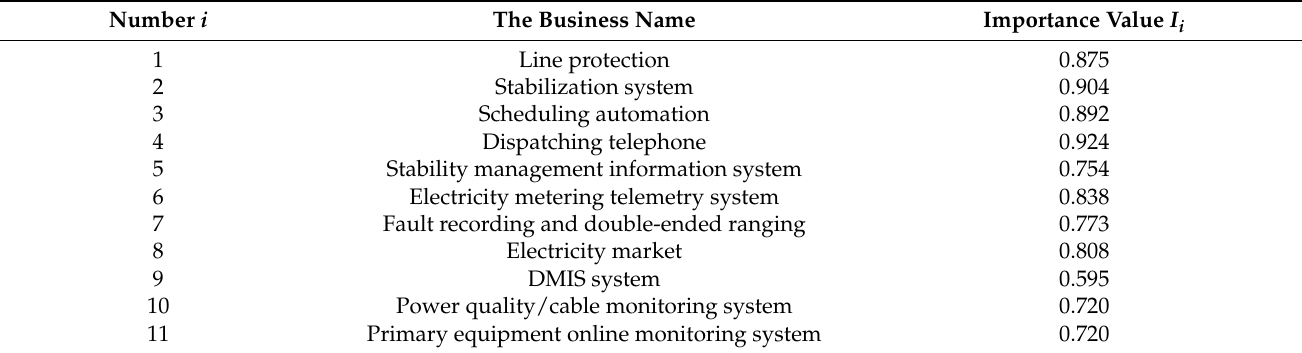
Table 8. The importance value I i of each information flow indicator item.